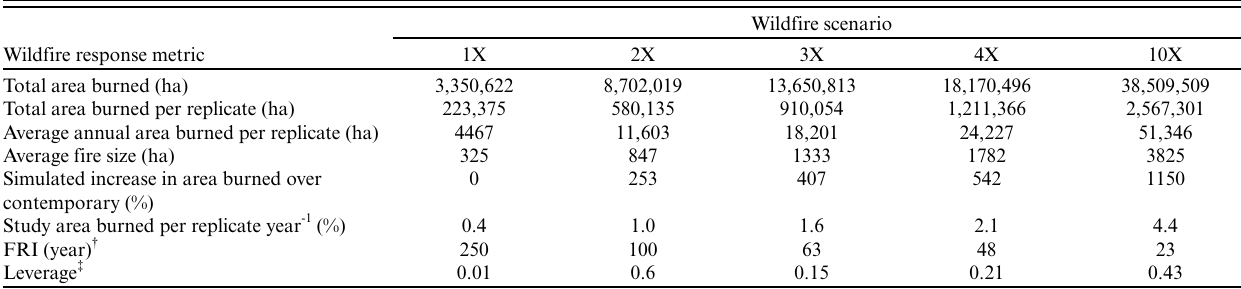
Table 2 . Wildfire response metrics per wildfire scenario over 50 simulated years. Increased levels of wildfire activity in each scenario were achieved by multiplying the burn period of each ignition over contemporary levels by the multiplier indicated. Wildfire scenario